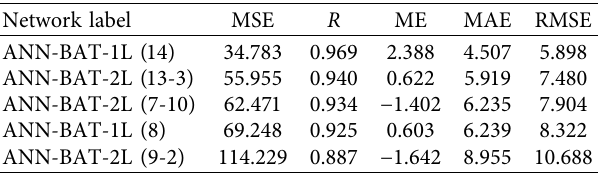
Table 5: Error metrics of the leading five networks for the testing